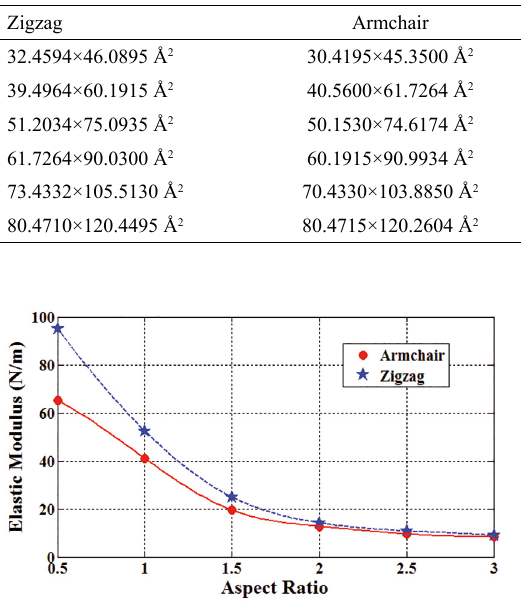
Figure 10: In-plane Young’s modulus of armchair and zigzag graphenylenes with the side length of 50 Å versus graphenylene aspect ratio.